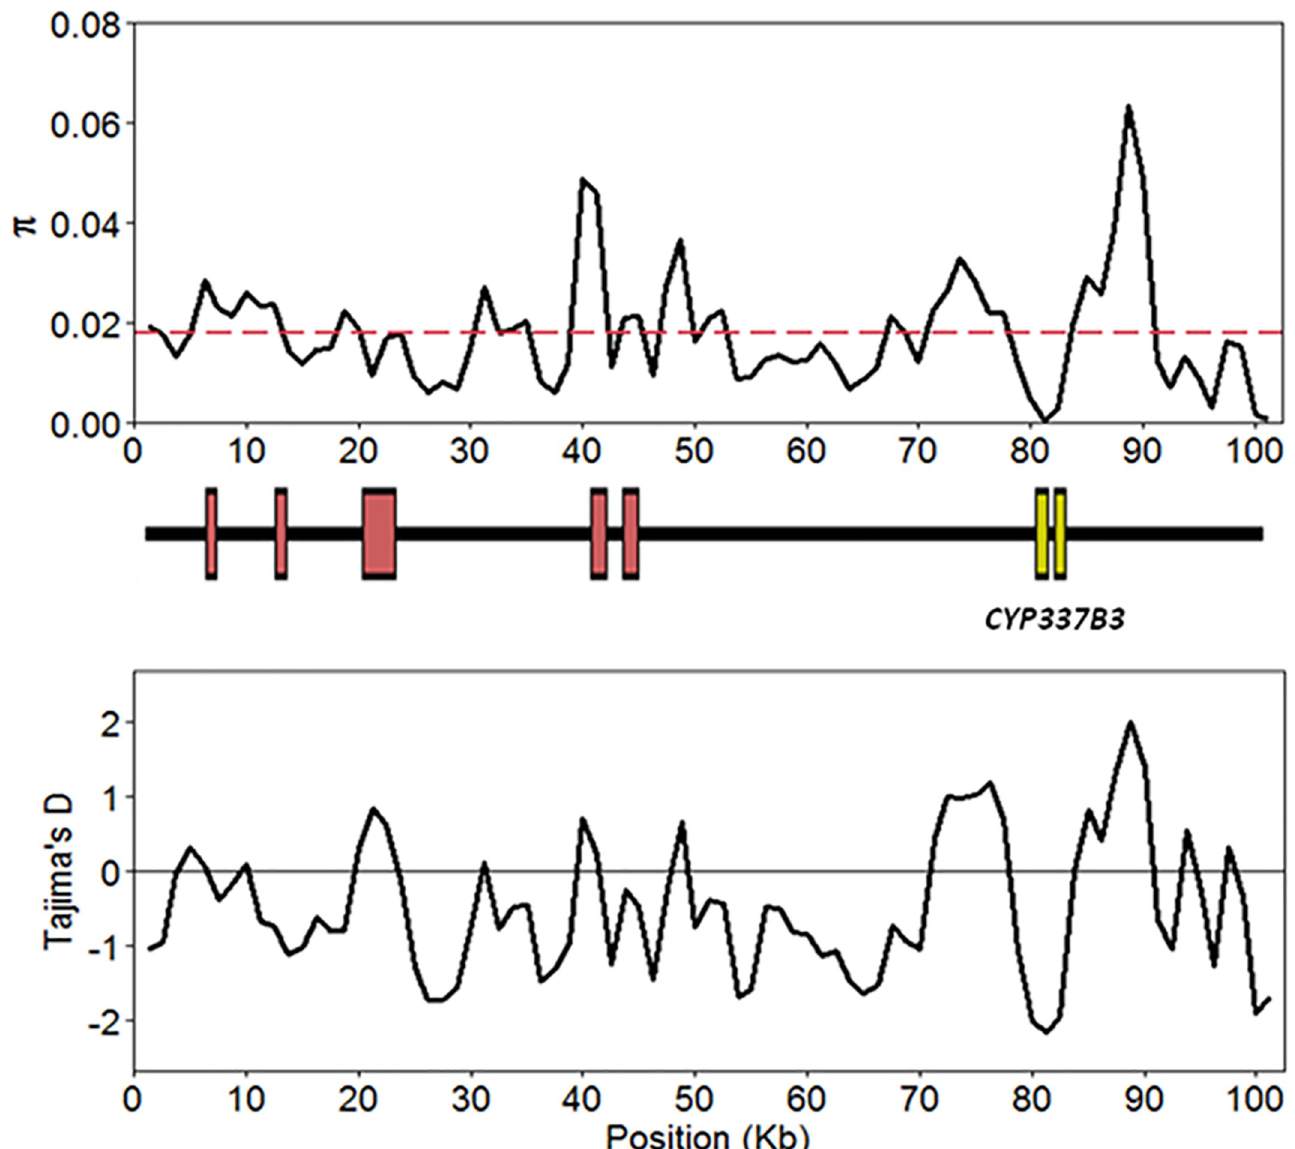
Fig 5. Selective sweep among Australian H . armigera homozygous for CYP337B3v1 . (a) Nucleotide diversity ( π ) and (b) Tajima’s D calculated across sliding windows of the 33J17 BAC (JQ995292.1), with the red dashed line showing the average value of π (0.0179). Locations of gene bodies are indicated between the plots, with those in red identified as potential reverse transcriptases and those in yellow as exons of CYP337B3v1 .